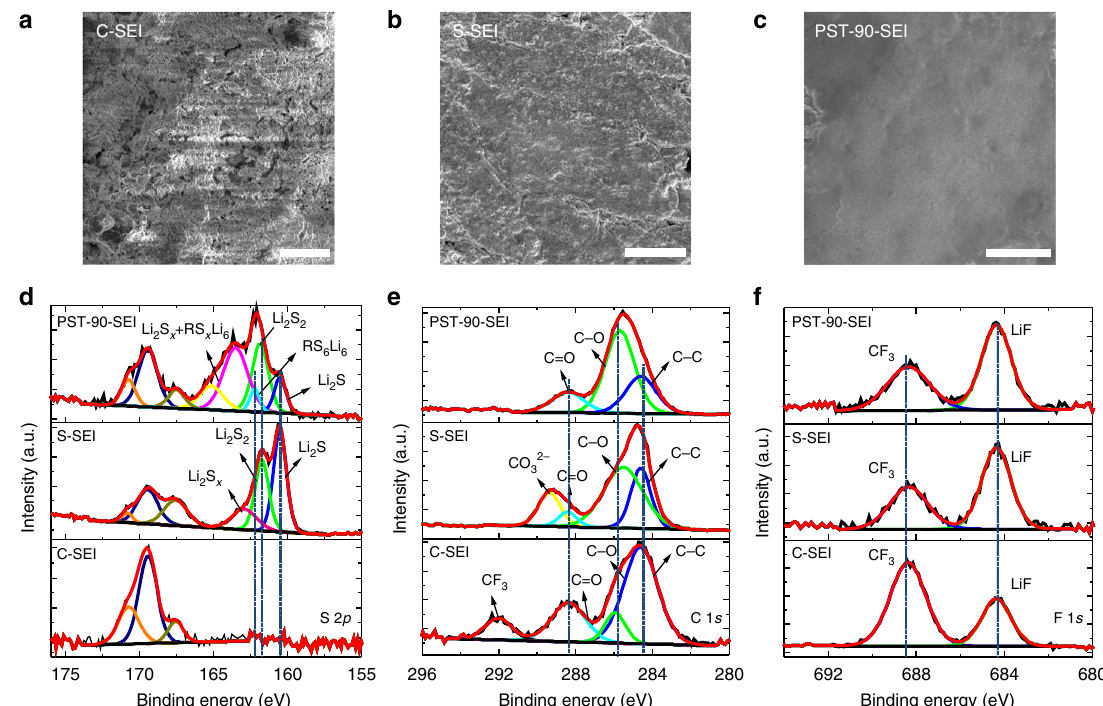
Fig. 3 The morphology and XPS spectra of SEI layers formed from the electrolytes containing different additives. a SEM image of C-SEI layer. b SEM image of S-SEI layer. c SEM image of PST-90 - SEI layer. S 2 p XPS spectra ( d ), C 1 s XPS spectra ( e ), and F 1 s XPS spectra ( f ) of the SEI layers formed from different